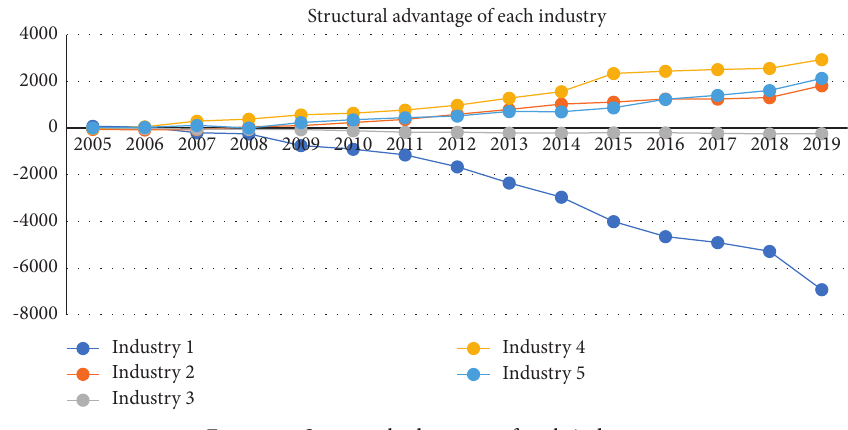
Figure 7: Structural advantage of each industry.